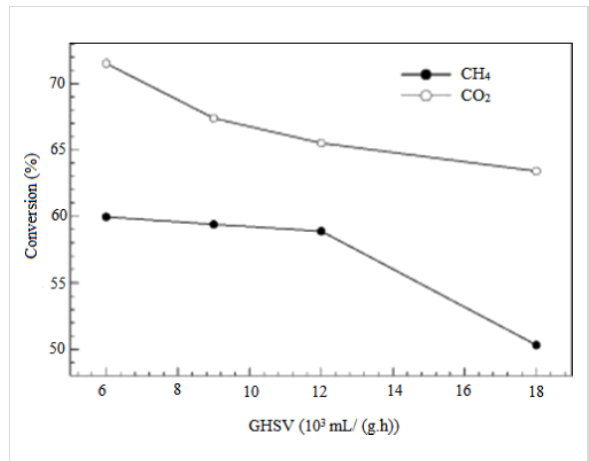
Figure 15: Influence of gas hourly space velocity (GHSV) on the cata- lyst performance of 20 wt % Ni/3 wt % MgO–Al 2 O 3 catalyst at a feed ratio CH 4 /CO 2 1:1, T = 650 °C. Reprinted with permission from [70], copyright 2014